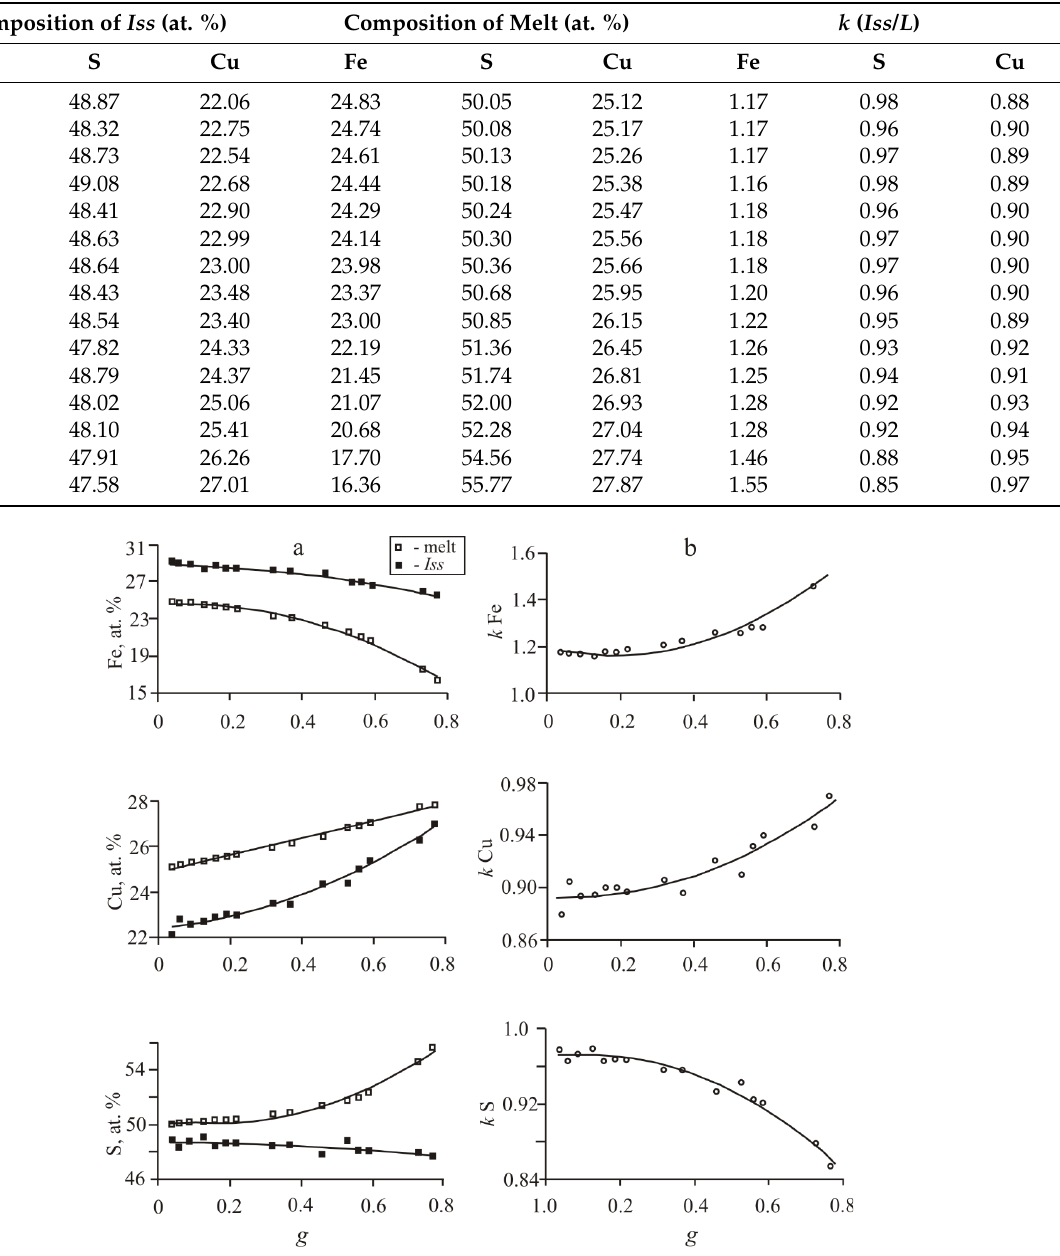
Figure 2. Distribution curves of Fe, Cu, and S in zone I of directly crystallized sample ( a ). Dependence of distribution coefficient of Fe, Cu, and S between Iss and melt on the fraction of crystallized melt g ( b ).